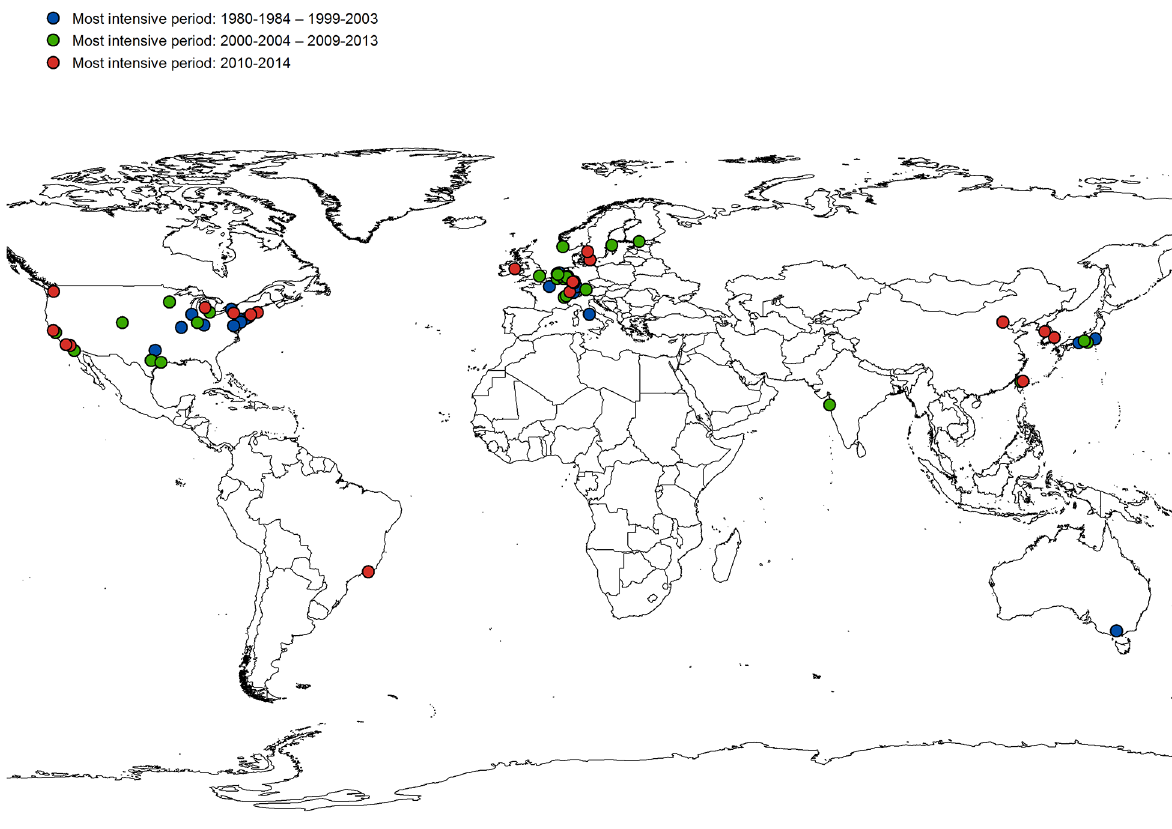
Fig. 1. Mapping spatial distribution of leading cities as centres of corporate R&D in light of the most intensive period of